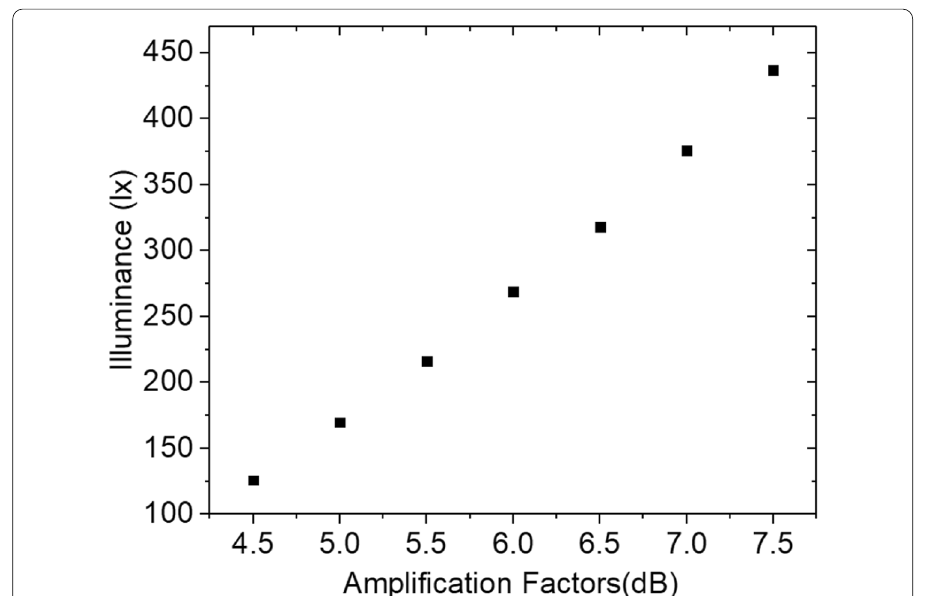
Fig. 5 Illuminance versus amplification factors of LED device under “constant bias voltage and constant frequency” operation